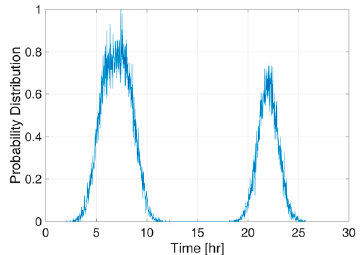
Figure 7. The start-on probability distribution of home appliances. ( a ) Microwave Oven; ( b ) Refrigerator; ( c ) Coffee Maker; ( d ) Clothes Washing Machine; ( e ) Regular Kitchen Appliances; ( f ) TV; ( g ) Laptops and PCs; ( h ) Gaming Tools; ( i ) Cooling; ( j ) Hair Drying; ( k ) Lighting; ( l ) Electric Kettle; ( m ) Dish Washer; ( n ) Clothes Ironing; ( o ) Cooling and Ventilation fans; ( p ) Battery Chargers and Voltage Adaptors.